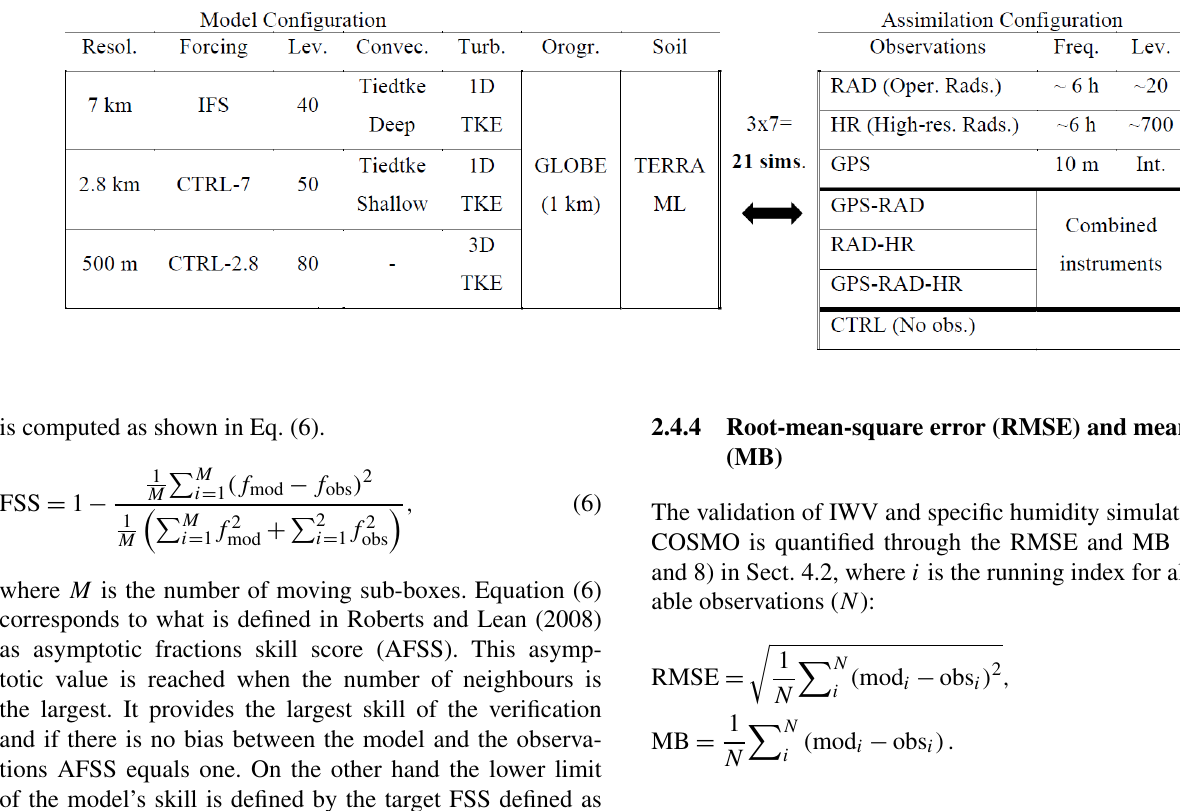
Figure 1. (a) Nested simulation domains for the different resolutions. (b) Spatial distribution of nudged measurements, GPS, operational radiosondes (RAD) and high-resolution soundings (HR), and investigation domains FR and RhoAlps (boxes). Table 1. Summary of simulations nudging radiosondes and GPS observations. In total 18 simulations with nudging plus three control runs were performed. The simulations with combined nudging of observations maintain the same assimilation frequency and number of levels for the different observations. The resolution of the GLOBE orography data set is 1km. The TERRA-ML model is used for the soil–atmosphere interactions